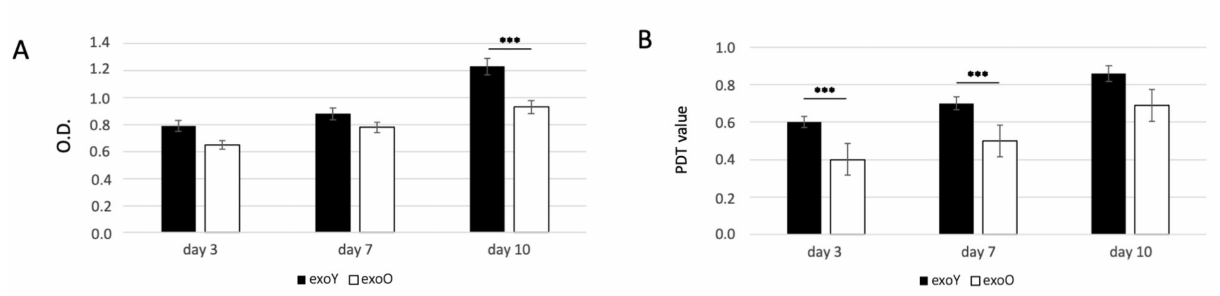
Figure 3. MTT ( A ) and PDT ( B ) assay of MSCs after treatment with exoY and exoO at 3, 7 and 10 days. *** p < 0.001.